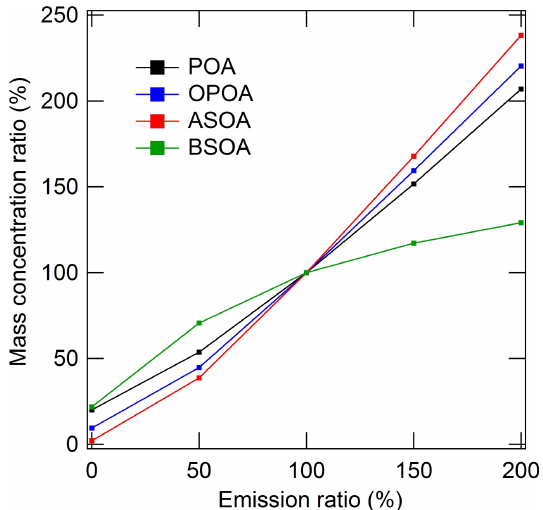
Figure 10. Sensitivity of POA, OPOA, ASOA, and BSOA mass concentrations to changes in anthropogenic emissions (CO, NO x , SO 2 , VOCs, S/IVOCs, POA and BC) at an altitude of about 1km over the outer domain. Mass concentrations and anthropogenic emissions in the sensitivity simulations are normalized by those in the base case